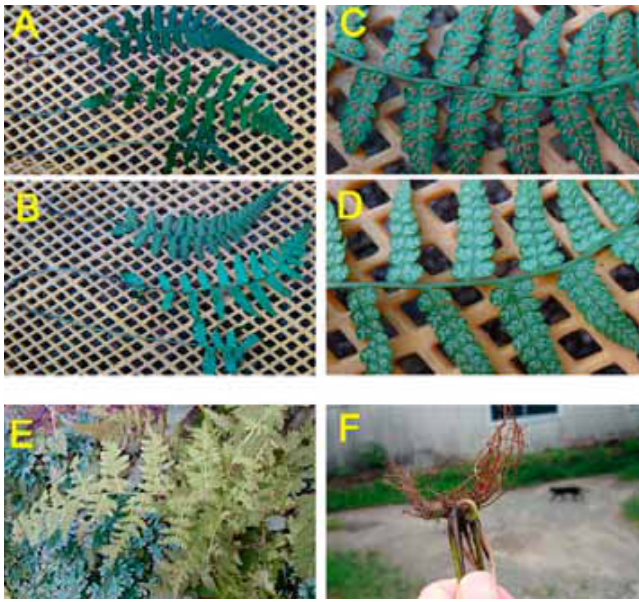
Fig. 3 - Deparia japonica and Pteridium aqualinum sampled in a pri- vate garden (Kiyotake-cho, Miyazaki, Japan). (A) Adaxial side (top side) and (B) Abaxial side (bottom side) of mature and young bladed of Deparia japonica . (C) Mature and (D) im- mature sporangia on leaflets of Deparia japonica . (E) Living Pteridium aqualinum . (F) Roots and young emerging frond of Pteridium aqualinum.